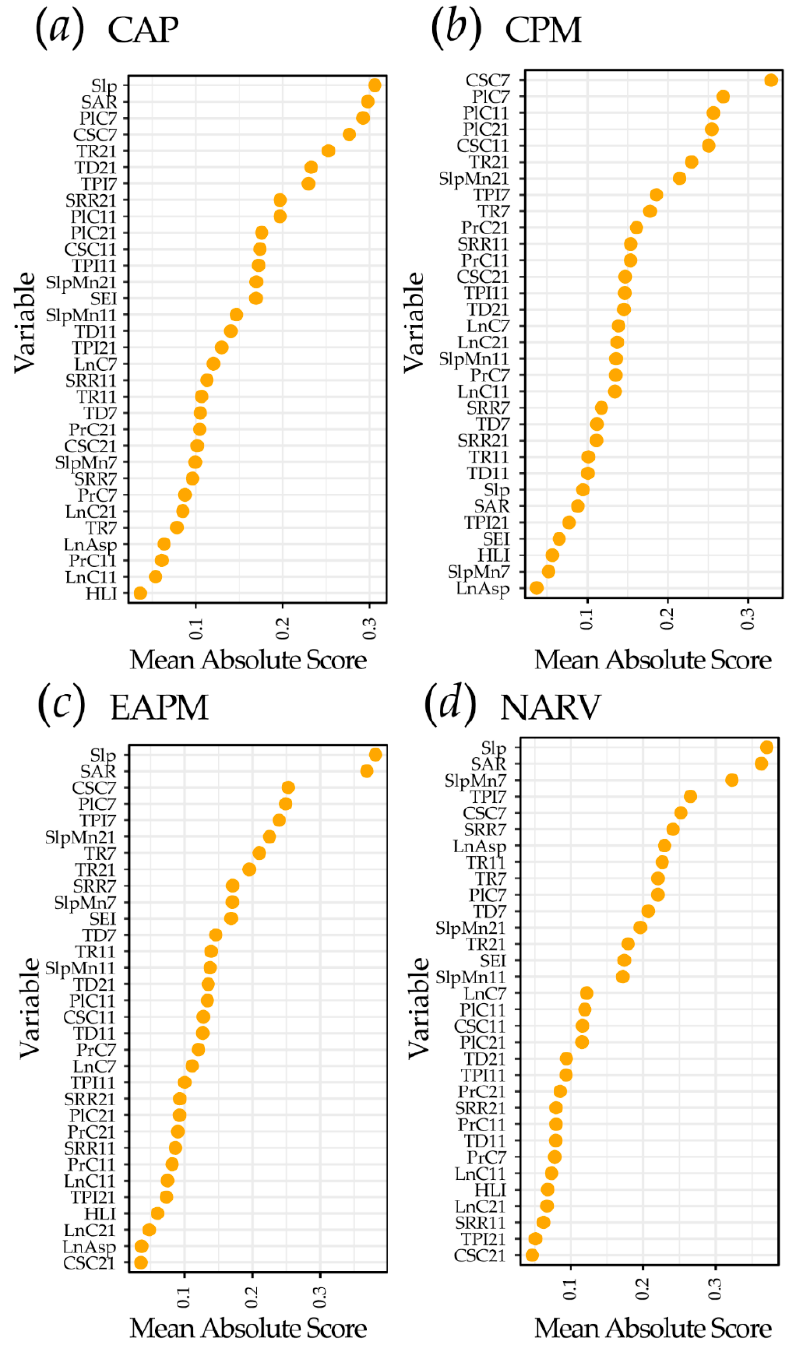
Figure 9. EBM variable importance estimates for each MLRA based on mean absolute score.